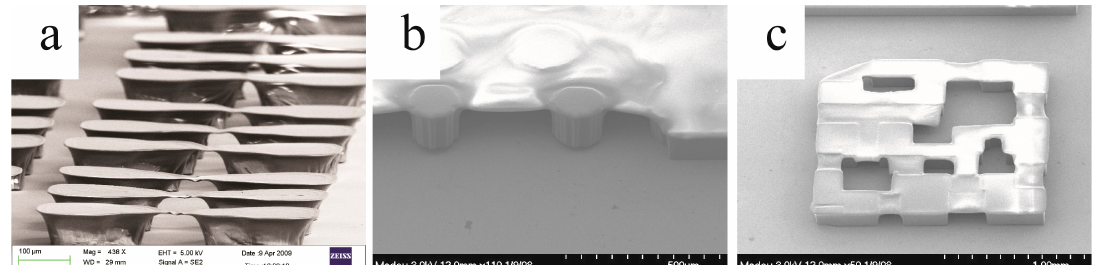
Figure 2. Examples of SU-8 structures fabricated using an SF-100 Grayscale Lithography equipment from Intelligent Micro Patterning: ( a ) Bridges, ( b ) A cover for a pillar array, and ( c ) Suspended structures of different